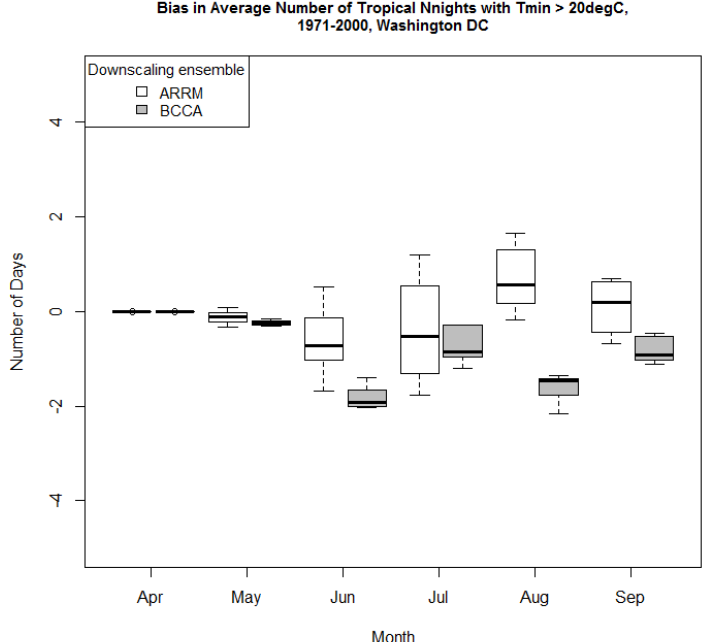
Figure 4. Absolute bias relative to Maurer02v2_1/8 observational dataset of the period mean number of tropical nights for Washington D.C., 1971–2000, as represented by the ARRM and BCCA downscaled GCM ensembles at 1/8° latitude resolution. Heavy line within each box plot represents the median.